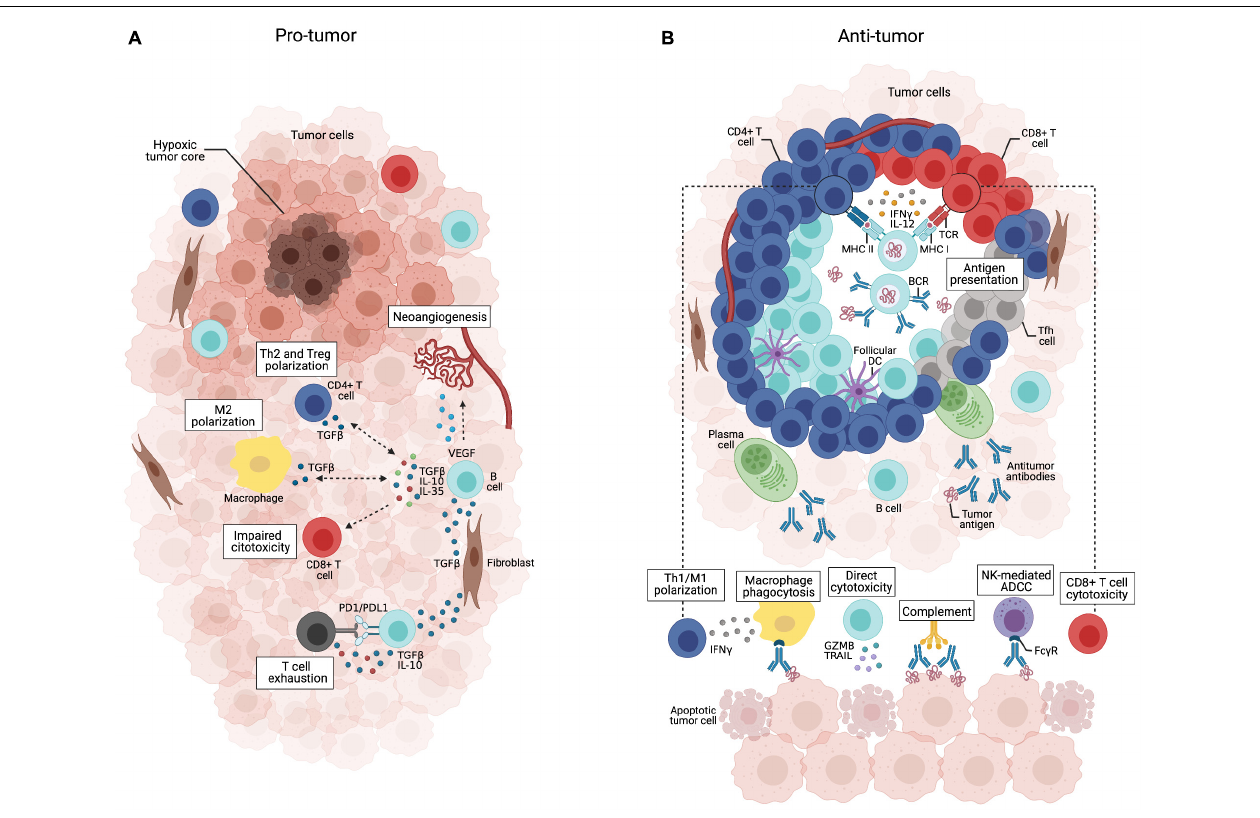
FIGURE 3 | Dual role of tumor-infiltrating B cells. (A) B cells scatteredly distributed throughout the tumor bulk may acquire immunosuppressive phenotypes in response to stimulation with TGF- β secreted by fibroblasts, Tregs or M2 macrophages. They can release IL-10, IL-35, and TGF- β that support Treg expansion and Th2/M2 polarization, while suppressing effector T cell activity, which is potentialized by B cell PD-L1 expression. VEGF-producing B cells may also promote tumor progression through neoangiogenesis. (B) Tumor-infiltrating B cells organized in well-structured TLSs coordinate anti-tumor immune responses through multiple mechanisms. They can present tumor-derived antigens to T cells and secrete cytokines such as IFN- γ and IL-12 that support Th1/M1 polarization and CD8 + T cell cytotoxicity. Tumor-specific antibodies secreted by plasma cells can trigger the complement cascade, mediate phagocytosis of tumor cells, and antibody-dependent cell cytotoxicity by NK cells. Activated B cells may also directly kill tumor cells by secreting TRAIL and granzyme